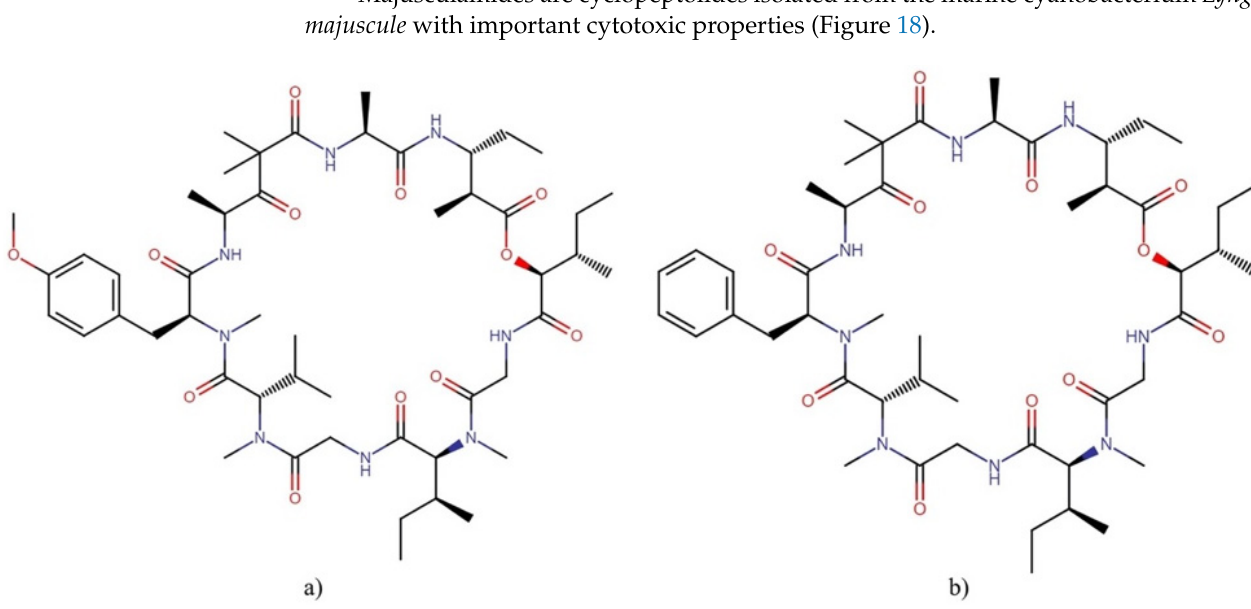
Table 9. Lyngbyabellin analog activities on cancer cell lines.